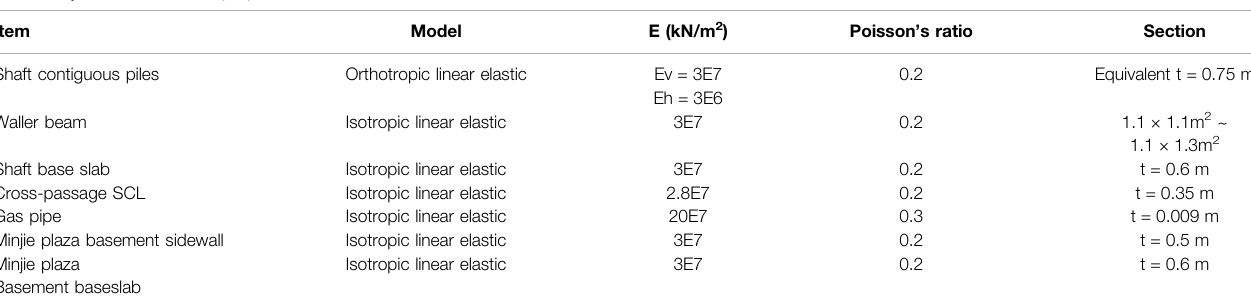
TABLE 2 | Structural element